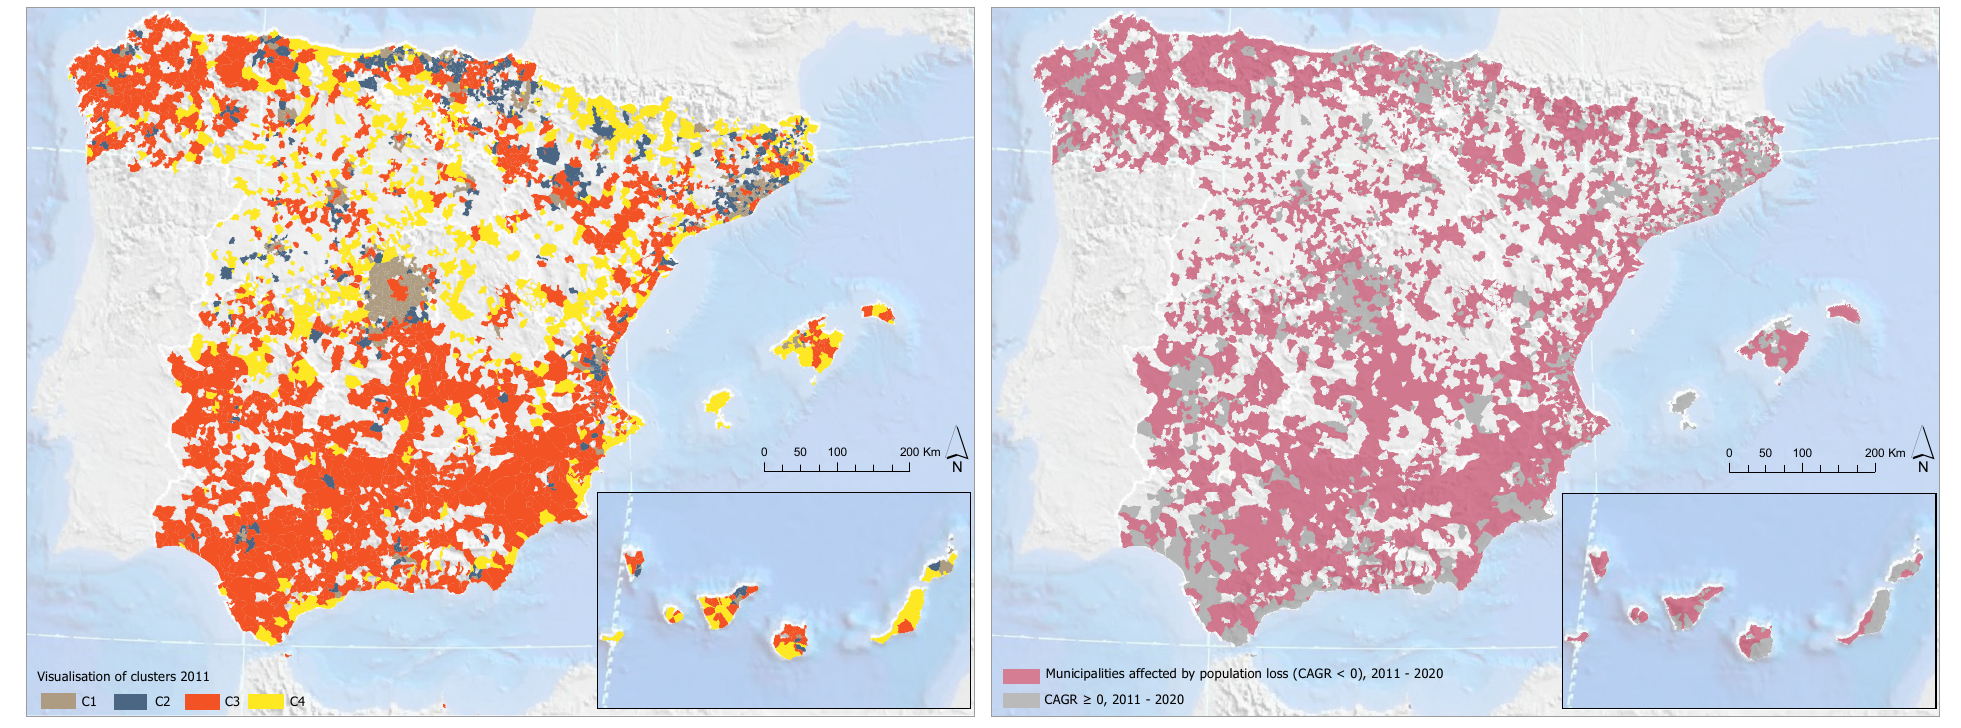
Figure A3. Maps showing the clusters of municipalities from a geographical perspective (part